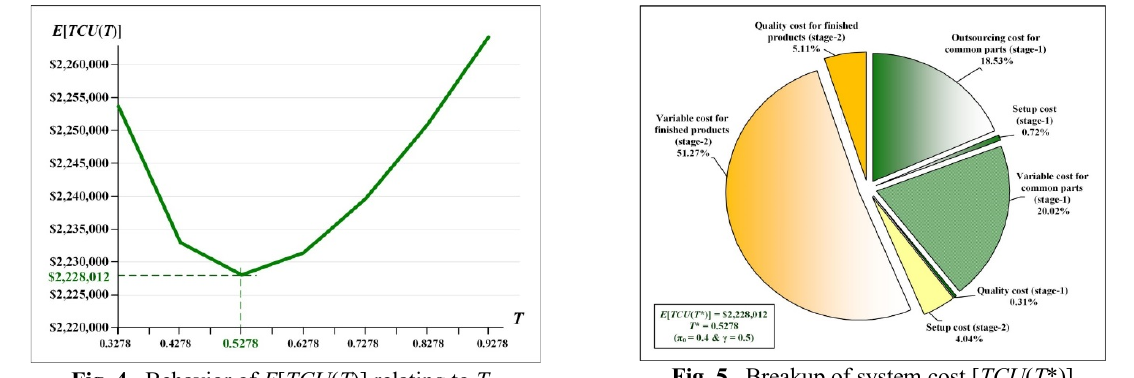
Fig. 4. Behavior of E [ TCU ( T )] relating to T Fig. 5. Breakup of system cost [ TCU ( T